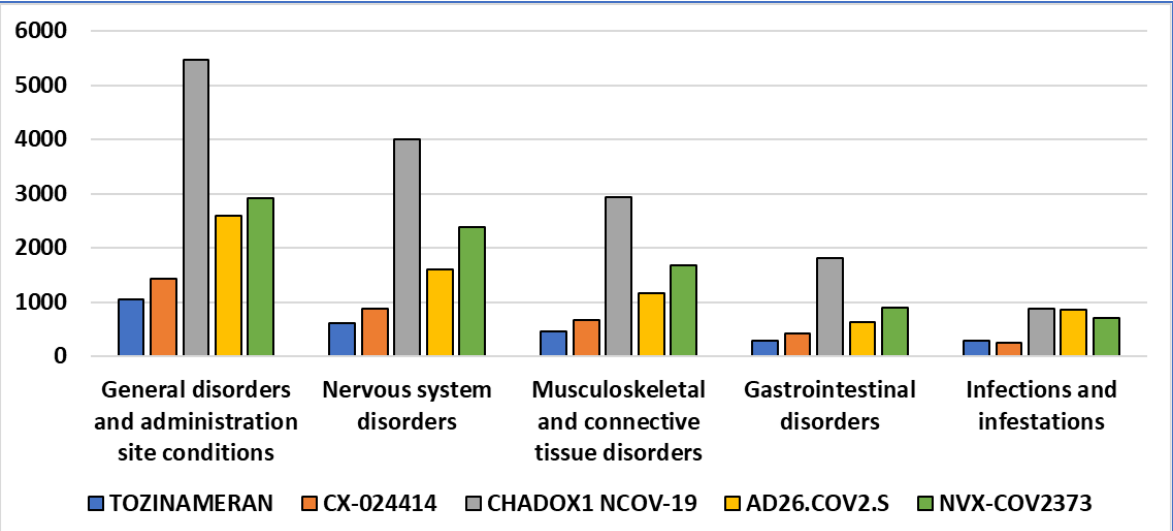
Figure 2. Relative frequency of Individual Case Safety Reports (ICSRs) on TOZINAMERAN, CX- 024414, CHADOX1 NCOV-19, AD26.COV2.S, and NVX-COV2373 in EudraVigilance European Da- tabase for Suspected Adverse Drug Reaction Reports (EDSADRR) on five predominantly common medical condition groups, with data normalization using the total number of administered doses (number of ICSRs per 1 million administered doses) (data on 17 September 2022, created by the authors based on statistical data [42,43]).